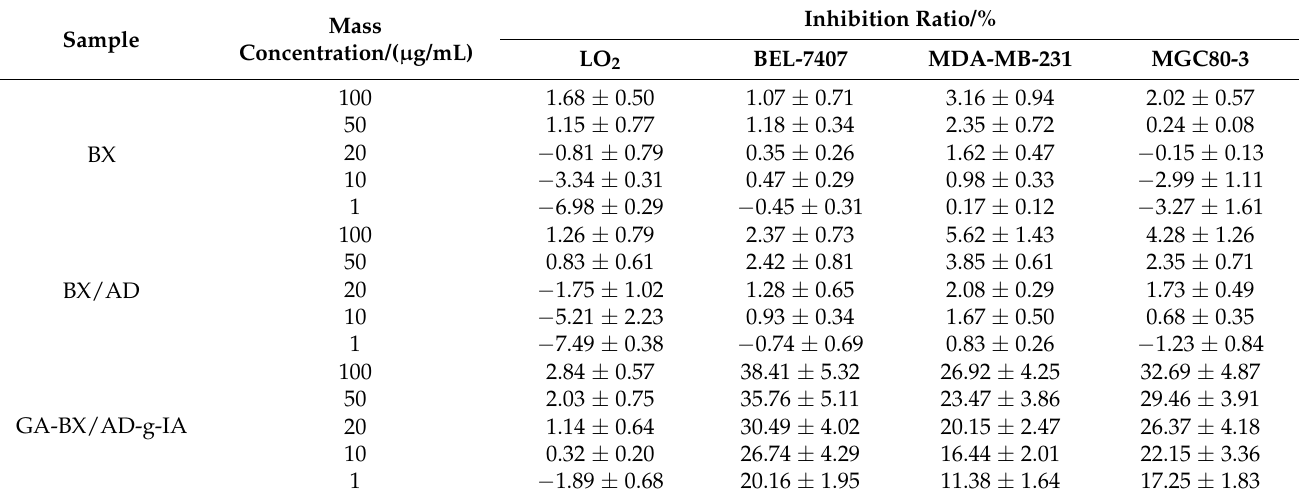
Table 3. The inhibition ratio of BX, BX/AD and GA-BX/AD-g-IA on different cancer cells and normal